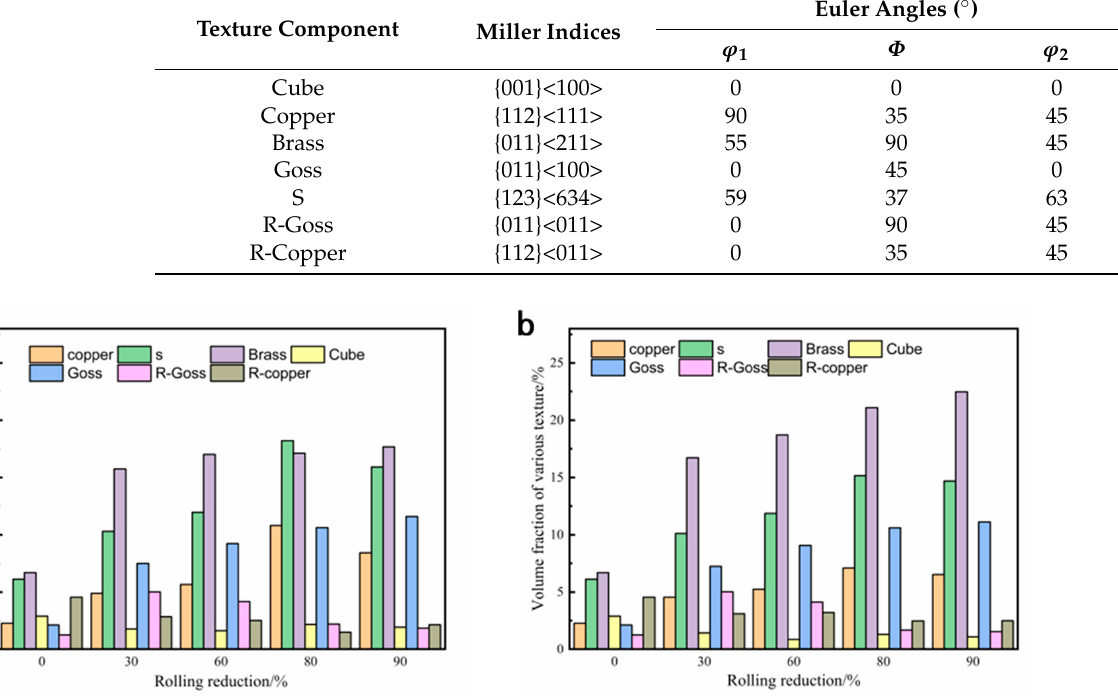
Figure 11. Variation in the volume fraction of various texture components with different rolling reductions at ( a ) room temperature and ( b ) cryogenic temperature.